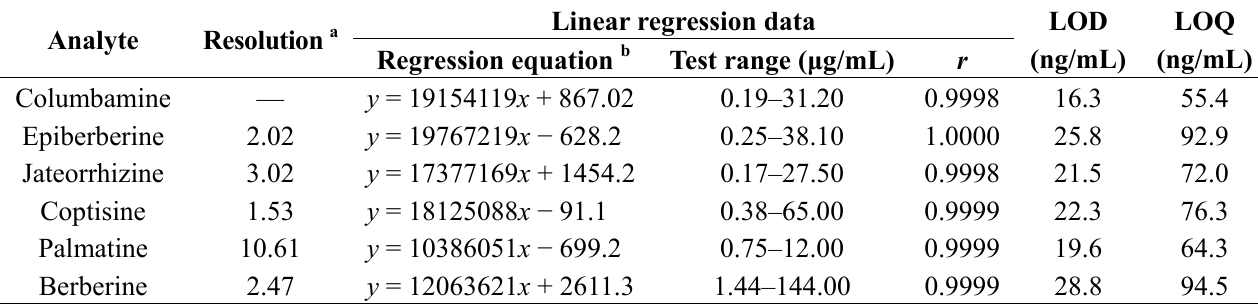
Table 2. Linear regression data, LOD and LOQ of the six investigated